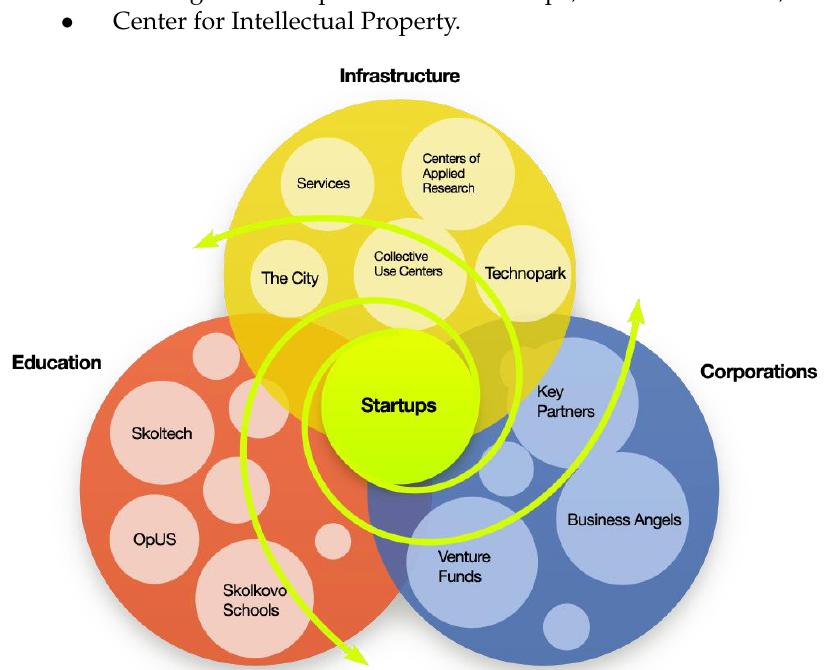
Figure 4. Skolkovo ecosystem. Source: Skolkovo Ecosystem. Available online: https://skolkovo-resident.ru/ekosistema-skolkovo/ (accessed on 10 May 2022).